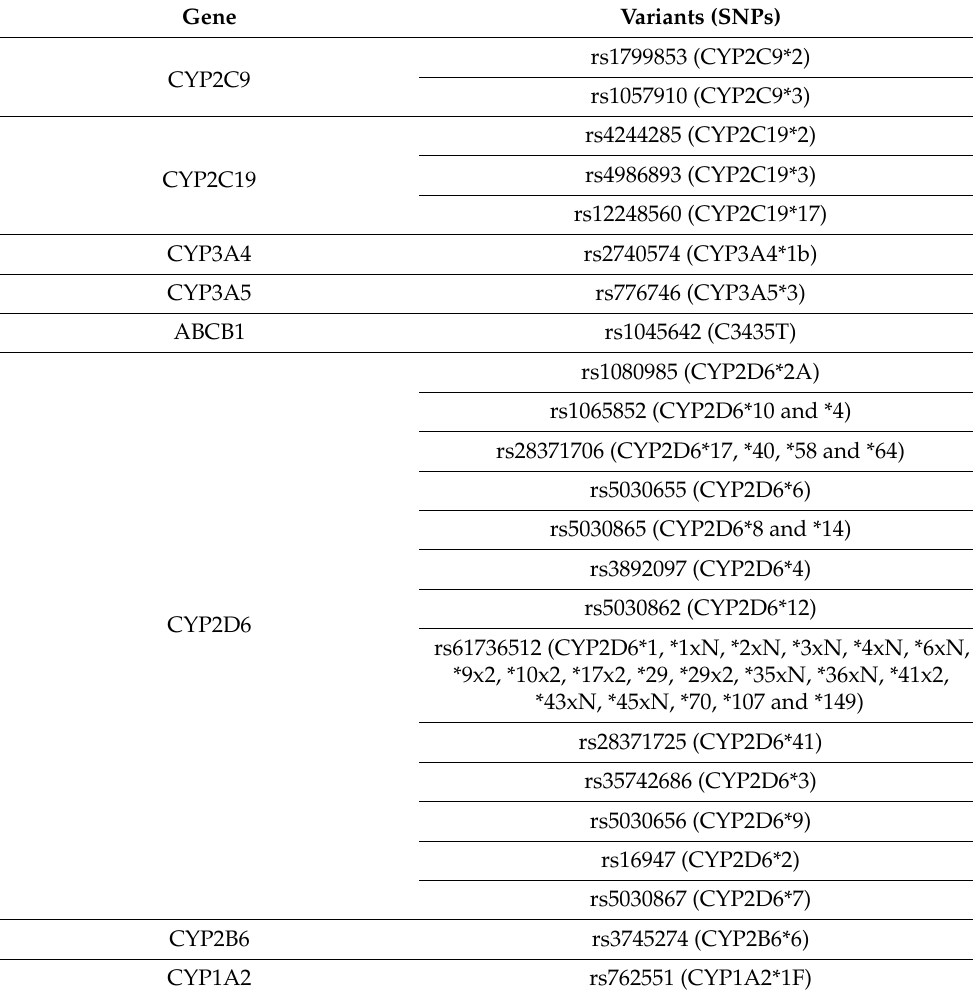
Table 4. Summary of variants